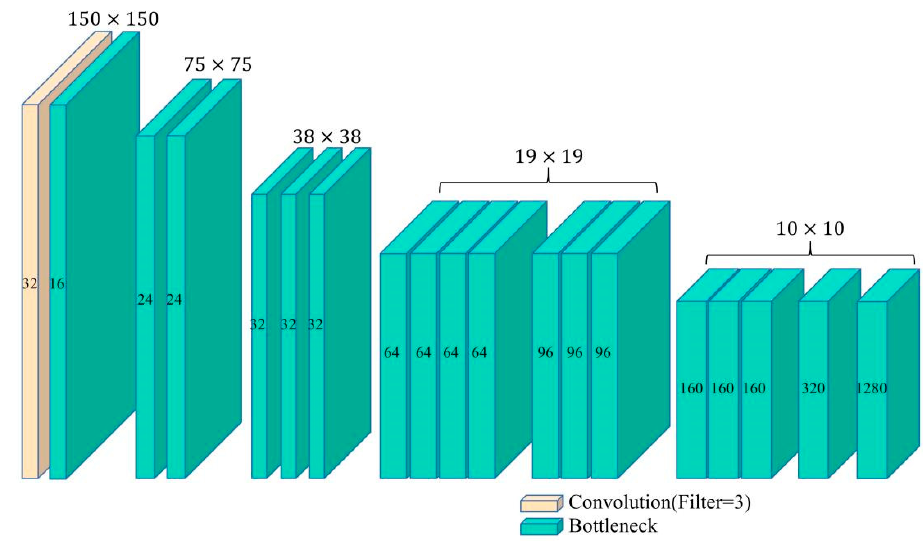
Figure 3. Structure diagram of MobileN etv2.